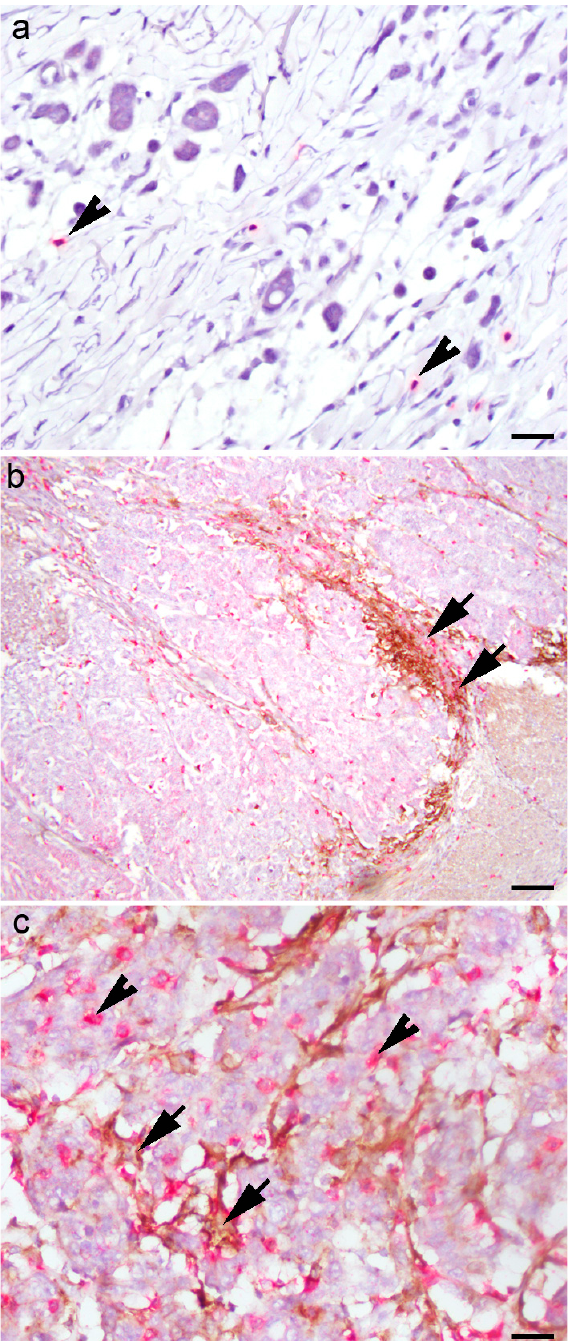
Figure 1. Double immunohistochemistry of PD-L1 and CD8 in tumor microenvironment of gastric cancer: ( a ) “desert landscape” with few CD8+ T immune cells (arrowheads) and PD-LI-negative tumor cells; ( b ) PD-L1-positive macrophages (arrows) in a broad front against PD-L1-negative tumor cells; ( c ) PD-L1-positive tumor cells intermingled with PD-L1-positive macrophages (arrow) and CD8+ lymphocytes (arrowheads). Scale bar ( a , c ) 50 µ M, ( b ) 80 µ